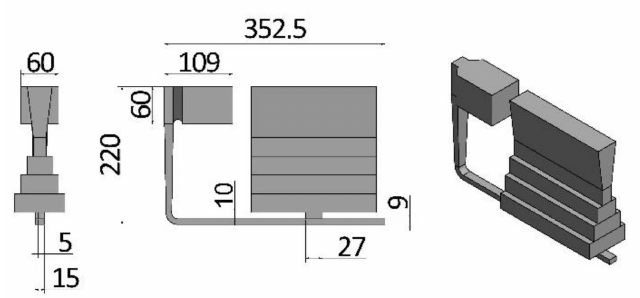
Figure 2. Naturally pressurized gating system without foam filter.